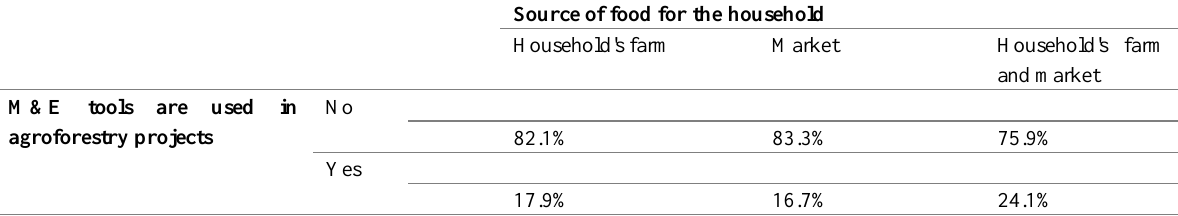
Table 17: Influence of use of M&E tools in agroforestry projects on source of food for the